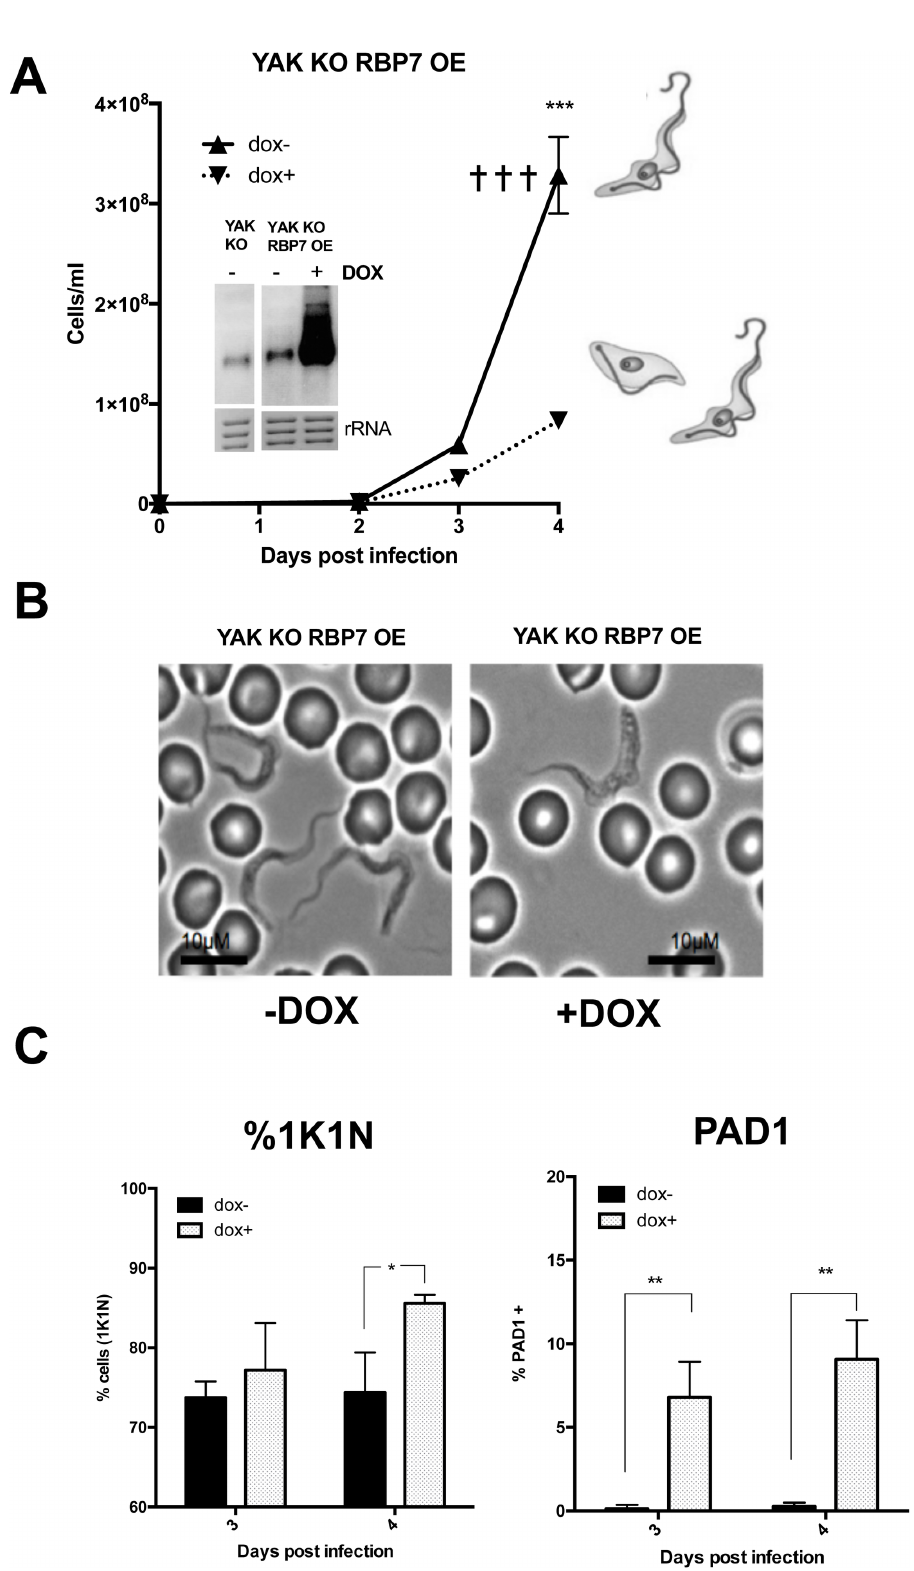
Fig 3. RBP7 ectopic expression induces stumpy formation in YAK null mutants in vivo .A. Growth of the YAK null mutant in which RBP7B ectopic expression was induced ( ▼ ), or not ( ▲ ) by provision of doxycycline in vivo . The